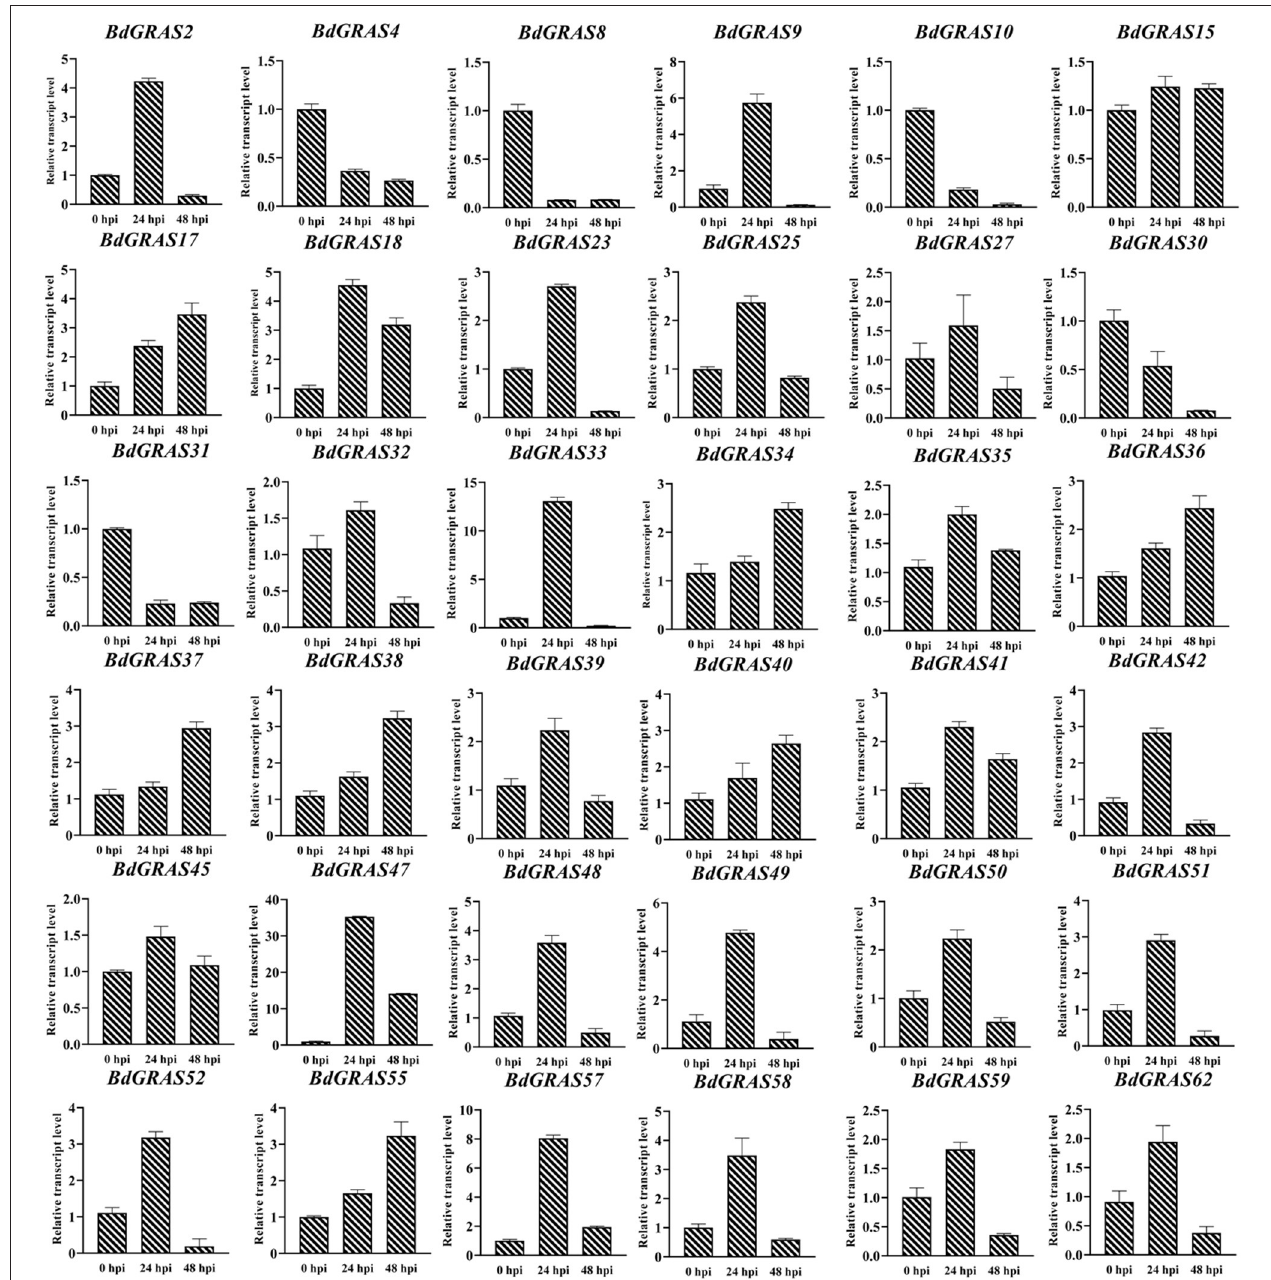
FIGURE 5 | qRT-PCR analysis of the expression pattern of BdGRAS gene after inoculation with Magnaporthe oryzae . The Y-axis is the relative expression of BdGRAS gene, and the X-axis is different time points after inoculation with M. oryzae , including 0, 24, and 48 hpi. UBC is used as an internal control (hour post inoculation, hpi).